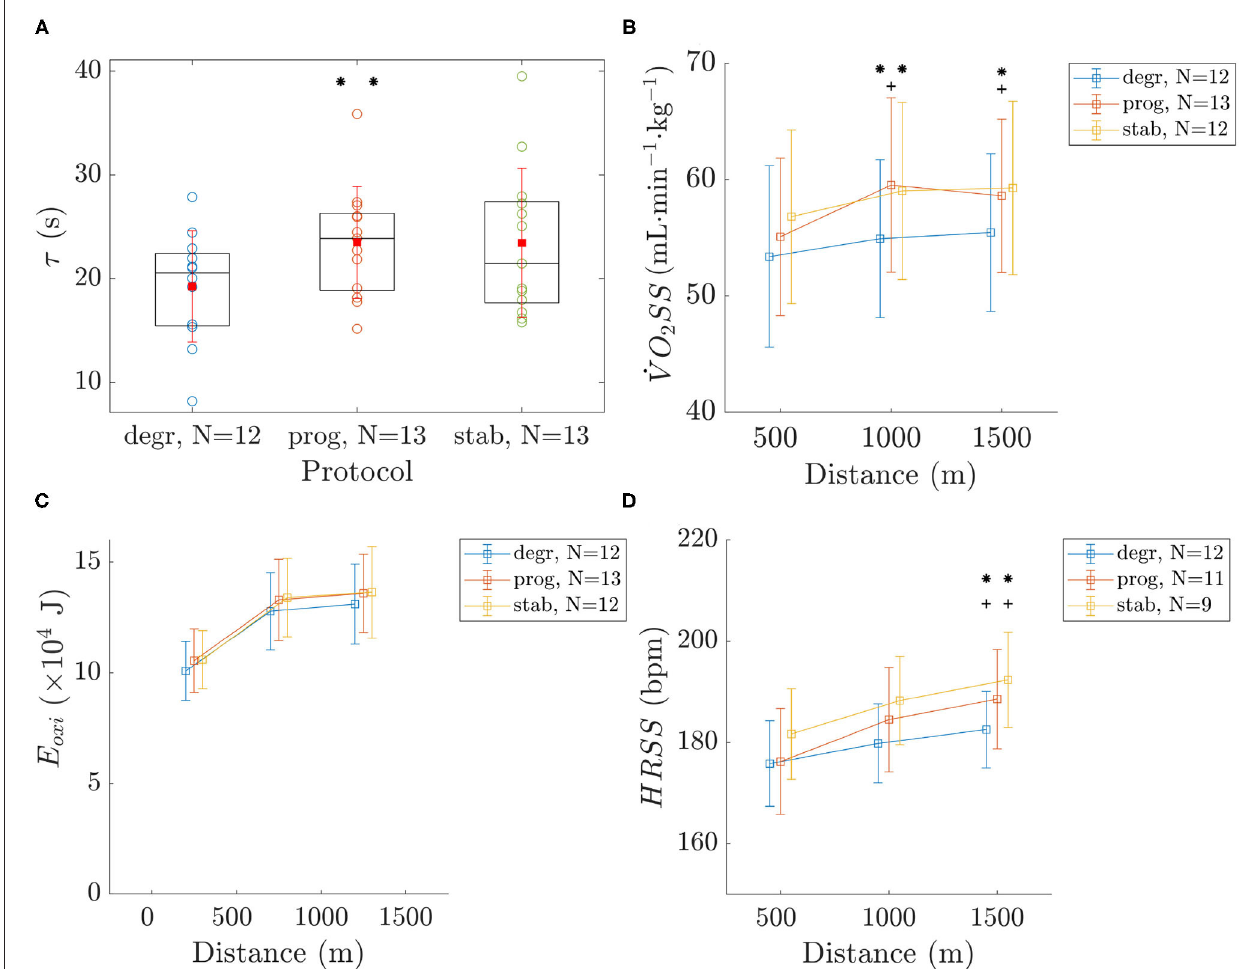
FIGURE 2 | τ (time constant of the primary response of the oxygen uptake on the first 500 m) (A) , ˙ VO 2 SS (B) , E oxi (C) , and HRSS (D) . Values are mean ± SD. The symbols ∗ and + indicate a significant difference between degr - prog and stab - degr , respectively. The number of symbols (one or two) indicate the p -value ( < 0.05 and < 0.01,